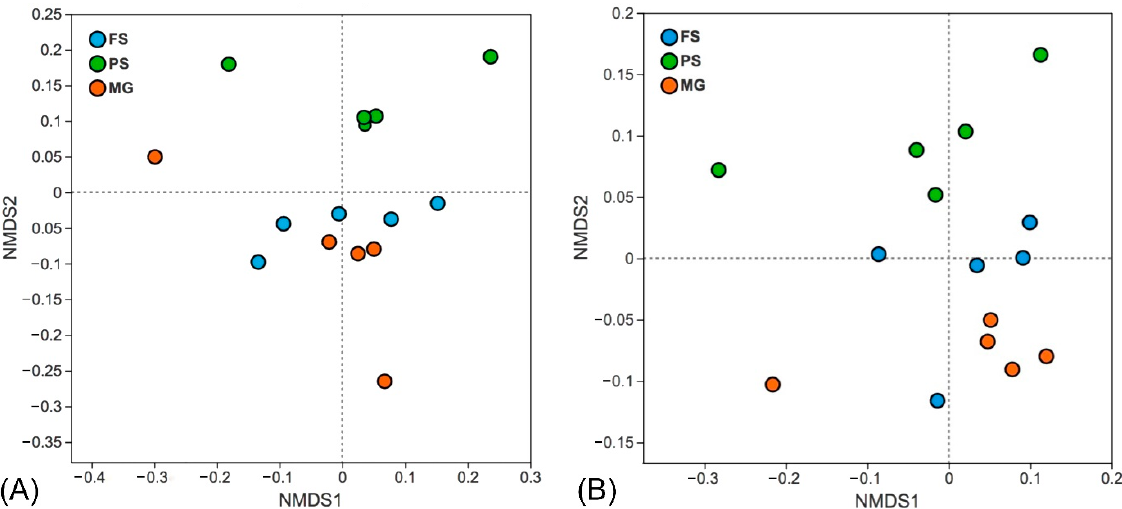
Figure 4. Nonmetric multidimensional scaling ordination of prokaryotic samples extracted by the FS, PS and MG kits based on Bray–Curtis distances ( A ) and unweighted UniFrac phylogenetic distances ( B ).